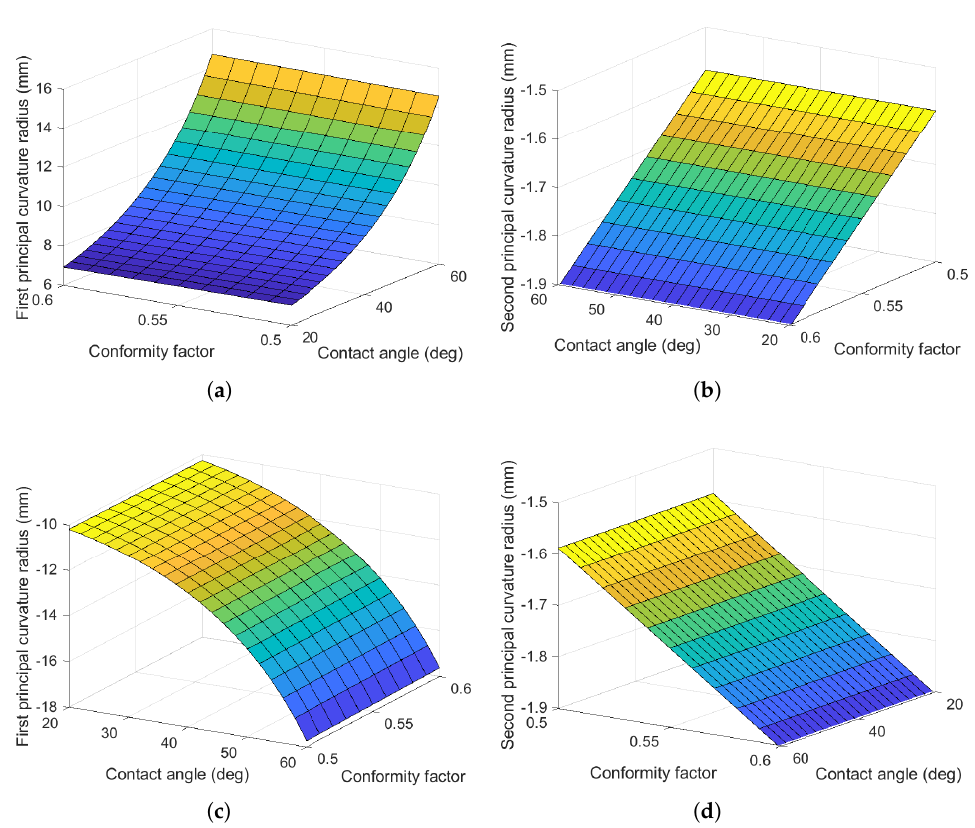
Figure 6. First and second principal curvature radii of the ( a , b ) screw shaft and ( c , d ) nut grooves depending on the contact angle and the conformity factor, for a ball screw with r m = 8 mm, α e = 5.6806 deg, r b = 1.5875 mm, ϕ 0 = 45 deg. Conversely, the conformity factor has a minor influence on the first principal curva- ture radius (Figure 6a,c), which is, instead, non-linearly dependent on the contact angle. The higher the contact angle, the greater the curvature radius and, hence, the lower the curvature. Indeed, the identified point on the groove would lie on a larger helix as the contact angle increases, and would therefore have less